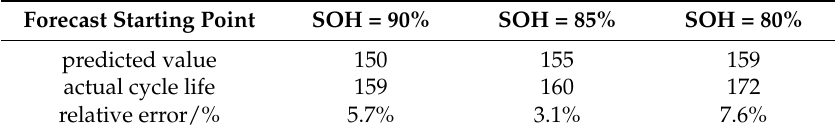
Table 1. The probability prediction results of the No.2 lithium battery cycle life.